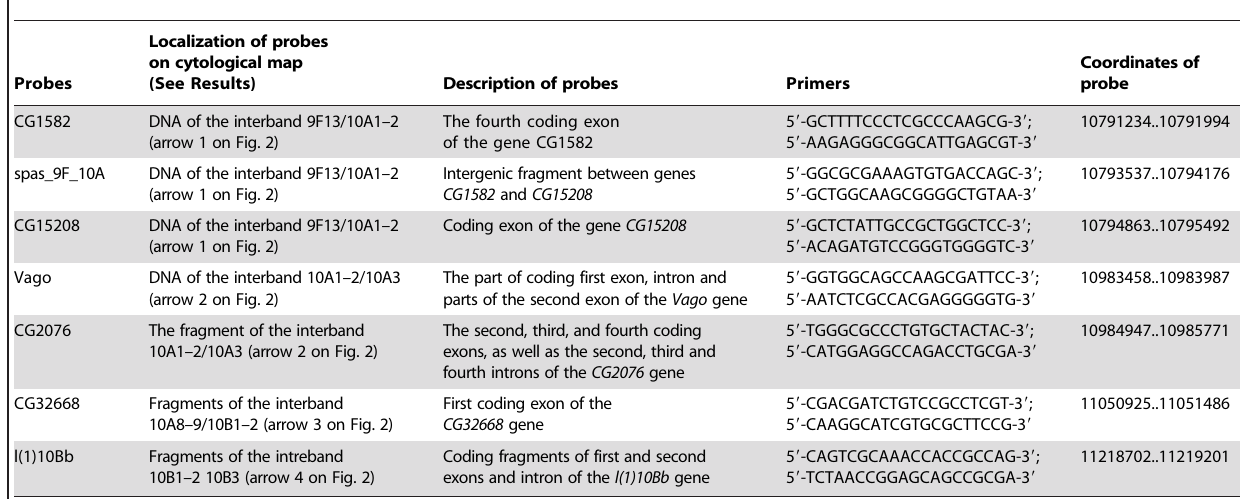
Table 3. Coordinates and descriptions of probes, selected for FISH mapping on polytene chromosomes in the region 9F13 – 10B3 (coordinates correspond to the version dm3 (r5.24),